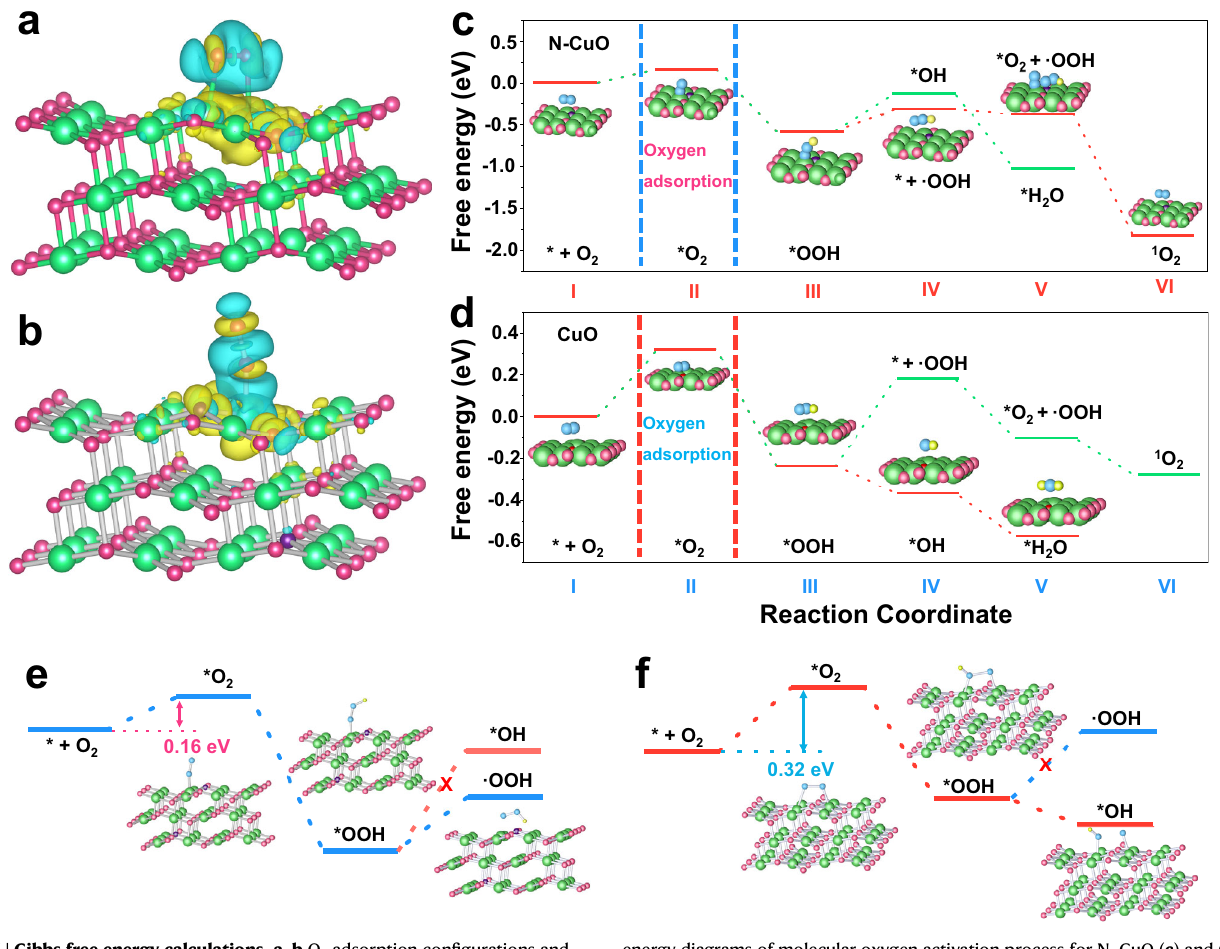
energy diagrams of molecular oxygen activation process for N – CuO ( c ) and CuO ( d ). Key steps of 1 O 2 production for e N – CuO (222) and f CuO